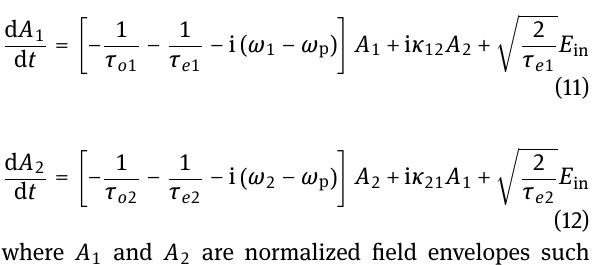
Figure 6: Simulated transmission of one resonator with two coupled modes. The first mode frequency is fixed while the second mode frequency moves across the first one. (A) Without mode coupling, κ = 0 . (B) With mode coupling, κ = i · 8.25 × 10 9 s −1 . The other parameters are as follows: τ o 1 = 2.79 × 10 −9 s , τ e 1 = 4.00 × 10 −9 s